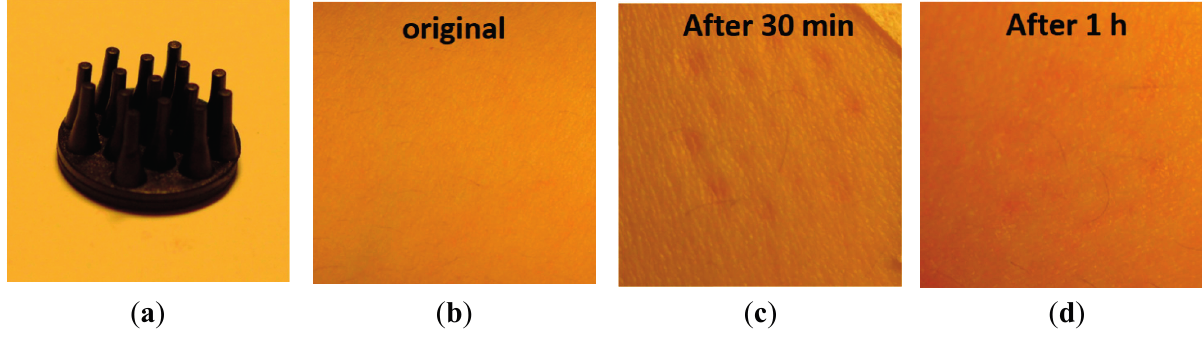
Figure 14. Skin irritation experiment for short term use of polymer electrodes ( a ) electrode with pins of 5 mm length; ( b ) Skin condition before and ( c , d ) after contact with long pin